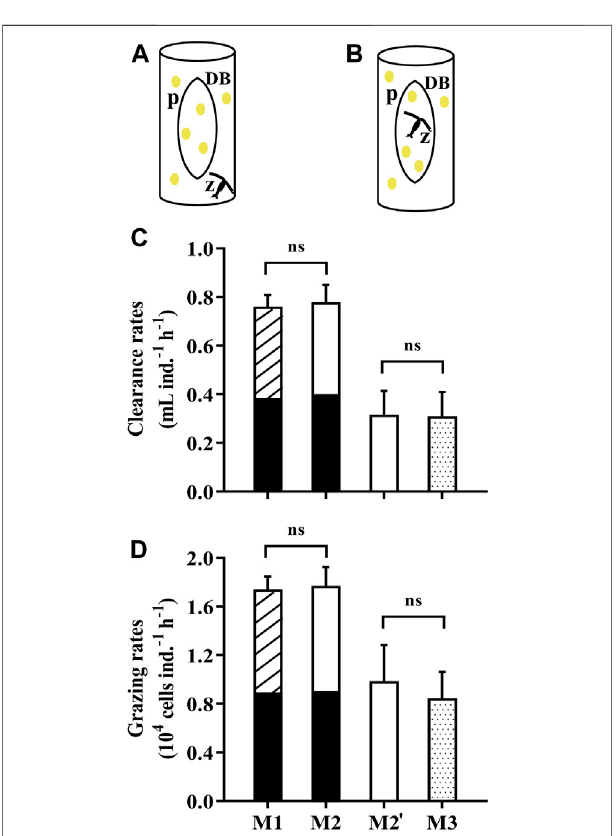
FIGURE 4 | (A) The dialysis bags holding the microalga Isochrysis galbana as the control to determine the grazing rates of the copepod Pseudodiaptomus sp. in an open vessel (1L beaker). (B) The dialysis bags holding microalgal cells and the copepod to determine the grazing rates with the phytoplankton in the vessel as the control. The letter “ p ” represents microalgae, “ z ” zooplankton and “ DB ” dialysis bags. (C) The clearance rates and (D) grazing rates of the copepod Pseudodiaptomus sp. on the microalga I.galbana measuredbyusingdialysisbagsindifferentways (A,B) .Speci fi cally, M1 represents the traditional method using vessels with and without the prey, whileM2 (A) andM3 (B) used dialysisbagswithinthevesselsasthecontrolor grazing tests, respectively. The comparison between M1 (striped over black bars) and M2 (white over black bars) was carried out over 8 h (4 h light, 4 h dark), while the comparison between M2 ’ (white bar) and M3 (dotted bars) was under the light conditions of 8 h. Data are the means ± SD, n = 3 (3 different replicates). Independent samples t-test was used to test the difference in the clearance rates and grazing rates between the methods, and signi fi cant differences were set at p < 0.05. The abbreviation ns stands for non-signi fi cant